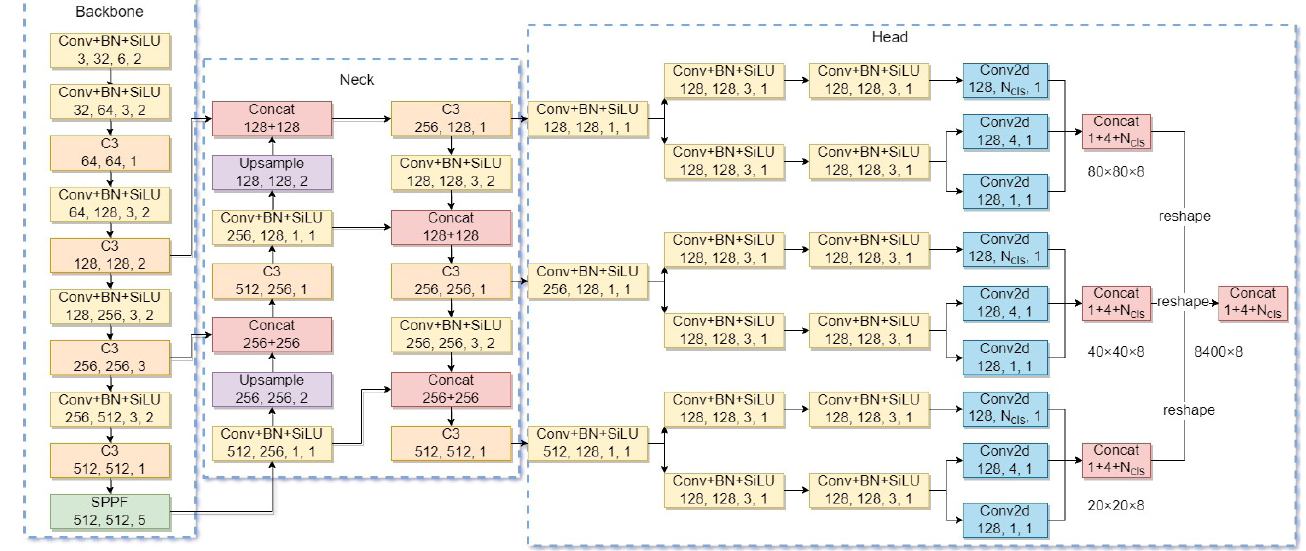
Figure 4. The diagram of YOLOsx network structure.